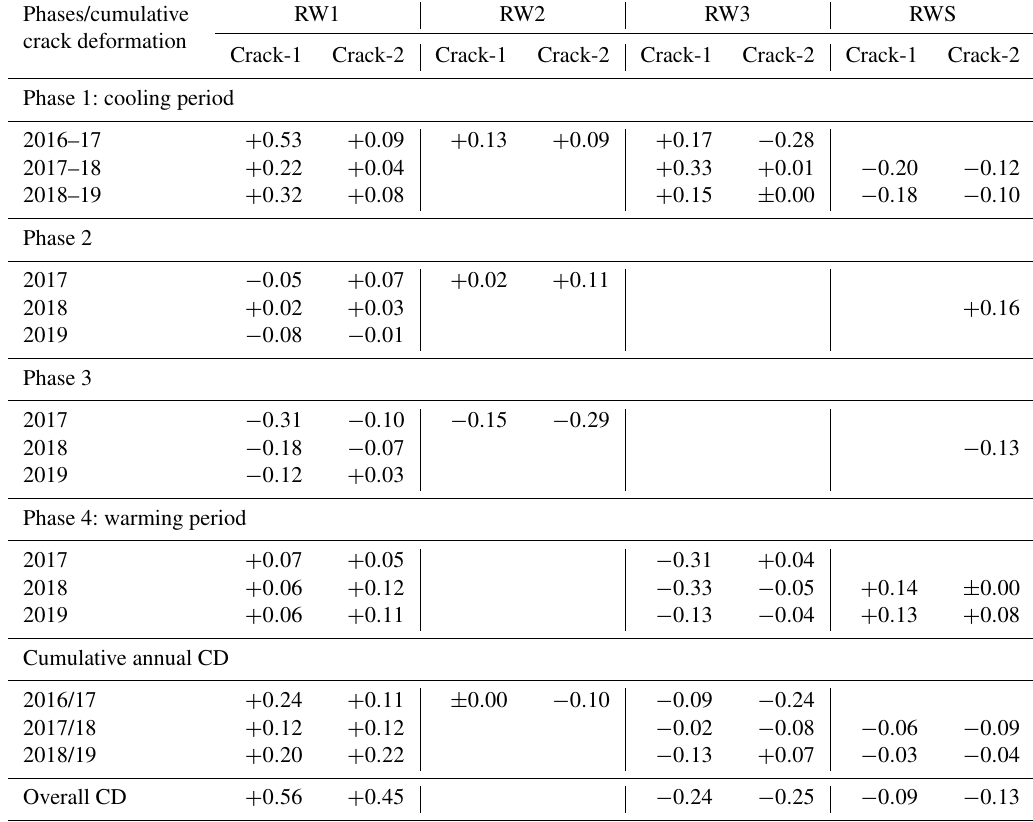
Table 4. Quantified rock fracture kinematic phases, annual and overall crack deformation in millimetres. Crack deformation (CD) is differ- entiated into crack closing ( − ), crack opening ( + ) and no CD ( ±